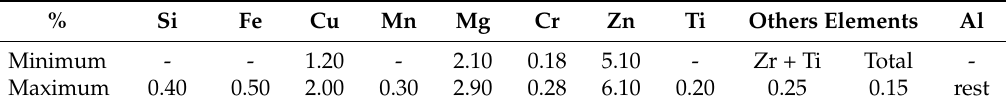
Table 1. AA7075 alloy